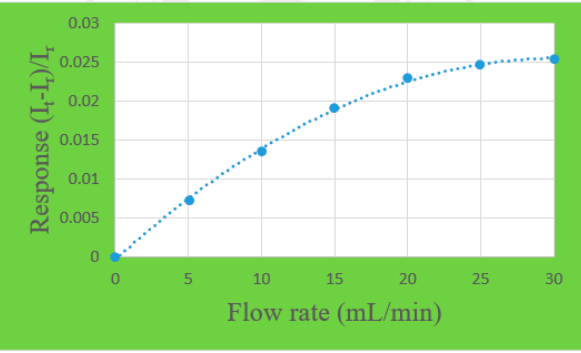
Figure 5. Correction curve of a micro flow sensor.